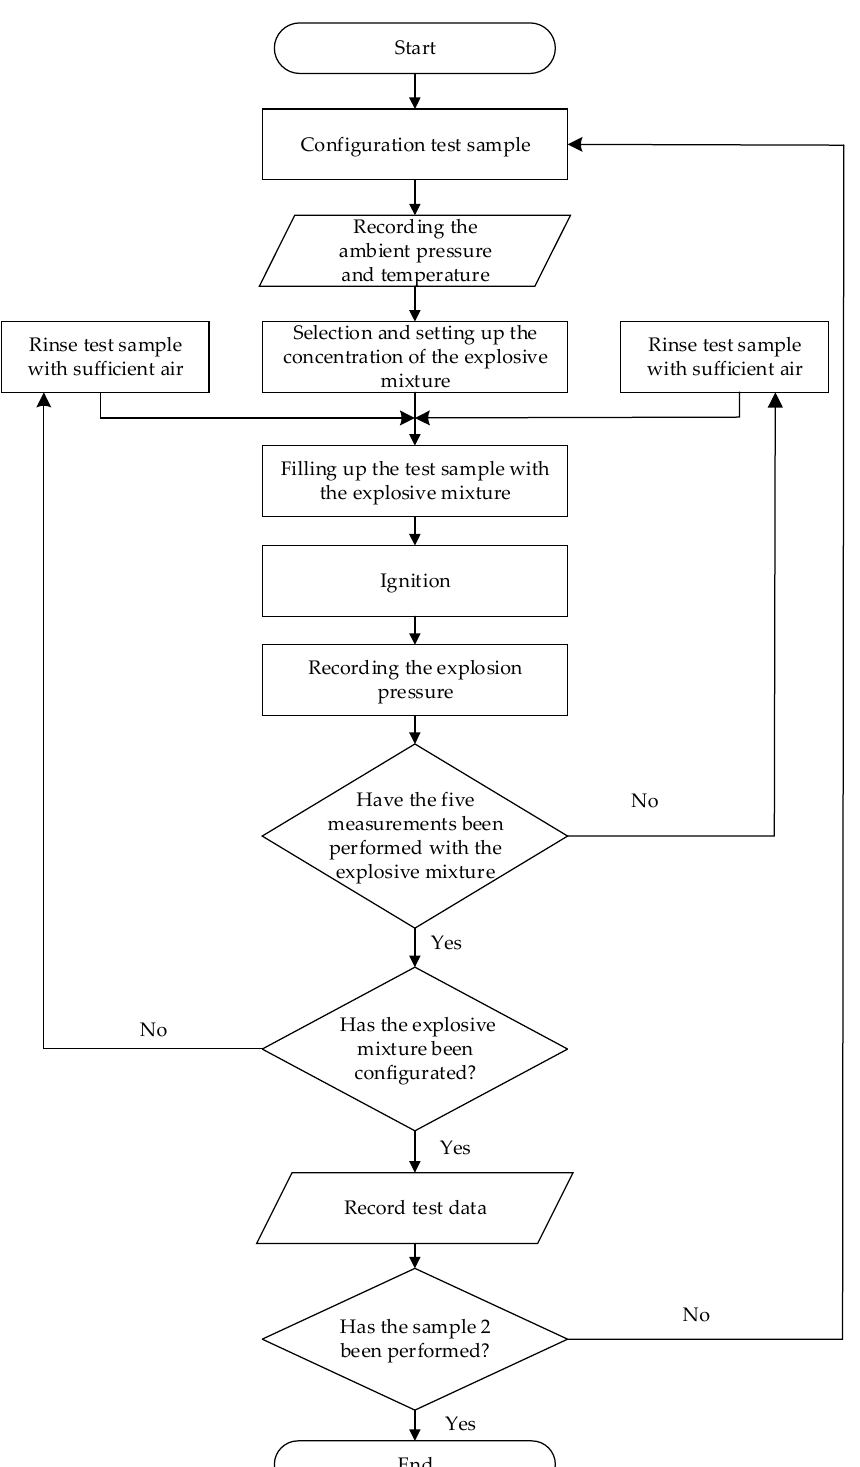
Figure 3. Experimental flow